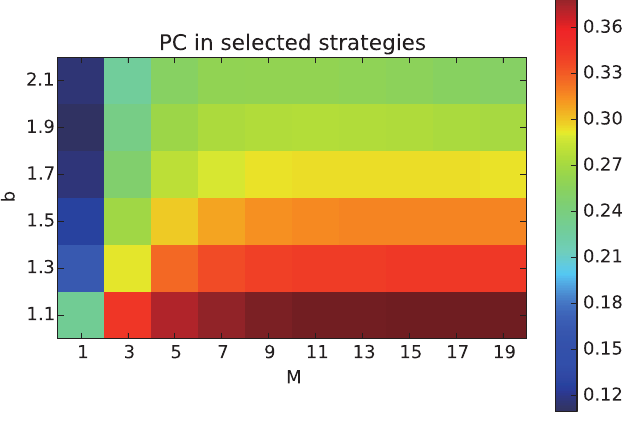
Figure 2. The proportion of cooperative behaviors among the selected strategies sp sl i in PC with increasing M and decreasing b showed that the multiplex network facilitated the evolution of cooperation in any conditions of the Prisoner’s